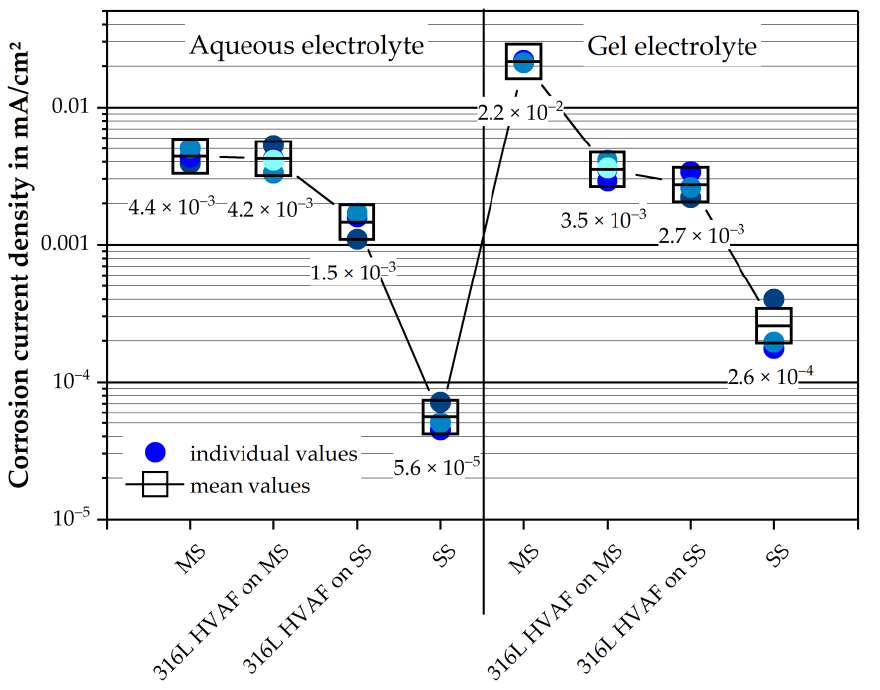
Figure 9. Corrosion current densities i Corr of reference material mild steel (MS), AISI 316L HVAF- sprayed coatings on mild steel (MS) and stainless steel (SS) and reference material stainless steel (SS) in 3.5% NaCl aqueous and gel electrolyte determined by Tafel